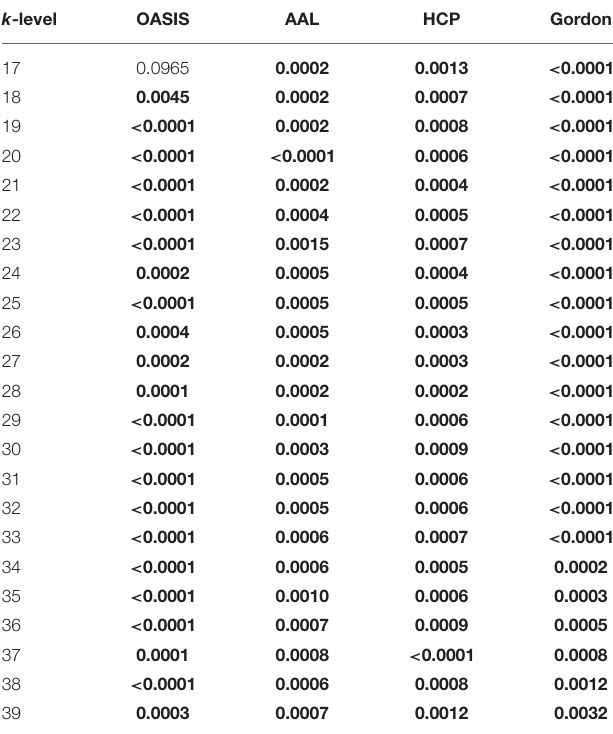
TABLE 6 | P -values of Kruskal-Wallis testing for rich-club coefficient differences among the NC, EMCI, LMCI, and AD groups. k